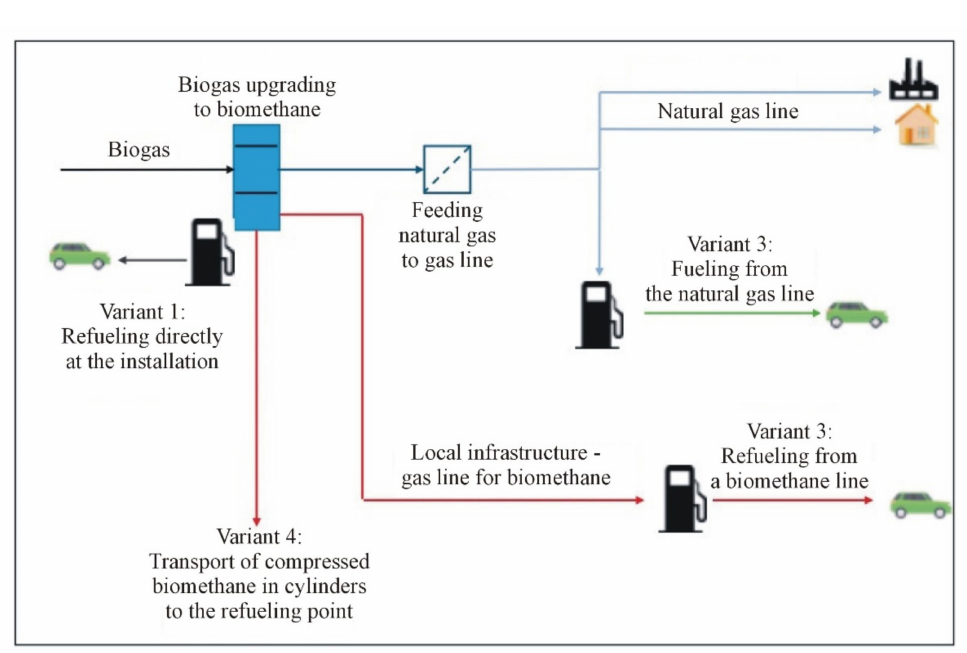
Figure 15. Possibilities of using BM as a fuel in vehicles in